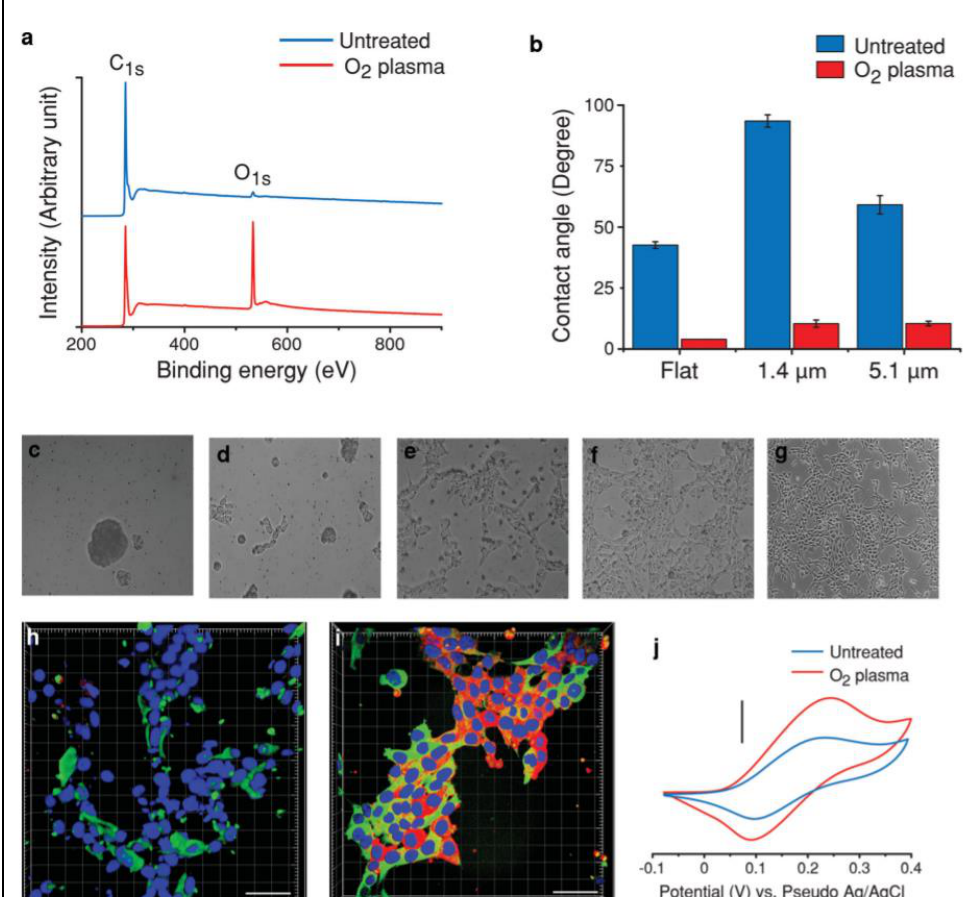
Figure 4. XPS characteristics of flat carbon before and after oxygen plasma treatment ( a ). Contact angle measurements on flat carbon and p3D-carbon ( b ). ( c – g ) Representative bright field images of hNSCs cultured in the presence of growth factors (48 h) on ( c ) untreated, ( d ) oxygen plasma-treated, ( e ) PLL-coated, ( f ) oxygen plasma-treated and PLL-coated flat carbon surfaces, and ( g ) PLL-coated TCPS. ( h , i ) Representative confocal fluorescence images of human NSCs cultured in the presence of GF (48 h) on ( h ) PLL-coated TCPS and ( i ) oxygen plasma-treated and PLL-coated flat carbon surfaces. Characteristic cyclic voltammograms of dopamine (5 mM) in PBS (pH 7) on a p3D-carbon before and after oxygen plasma treatment ( j ). Reproduced with permission from Ref. [81]; copyright (2014), John Wiley and